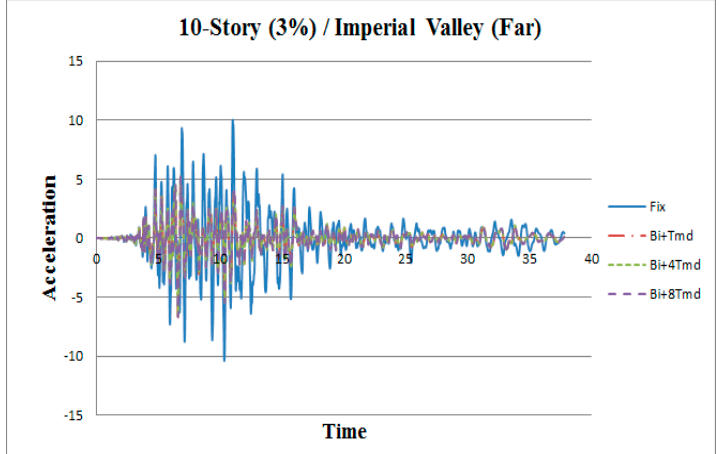
Figure 2. Acceleration time histories for top story of 10-story building under the Imperial Valley (far-fault) earthquake.